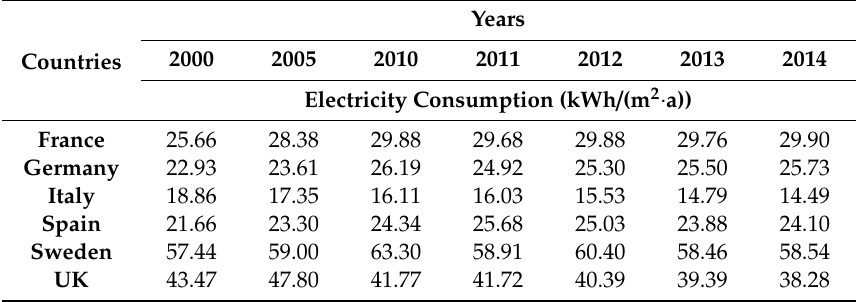
Table 3. Average of electricity consumption for electrical appliances and lighting per electrified household (kWh / (m 2 · a))